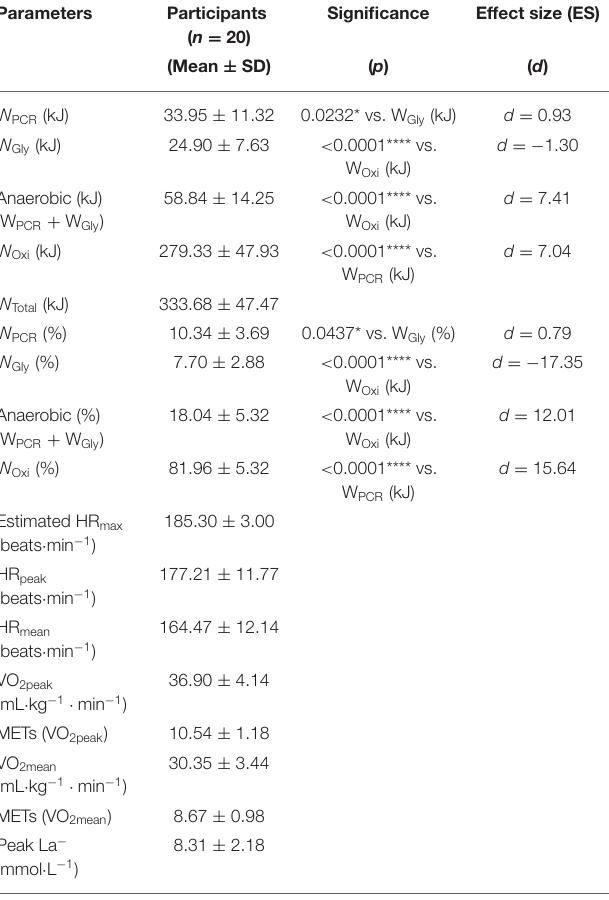
TABLE 2 | Energetic contribution and physiological parameters during high-intensity hatha yoga. Parameters